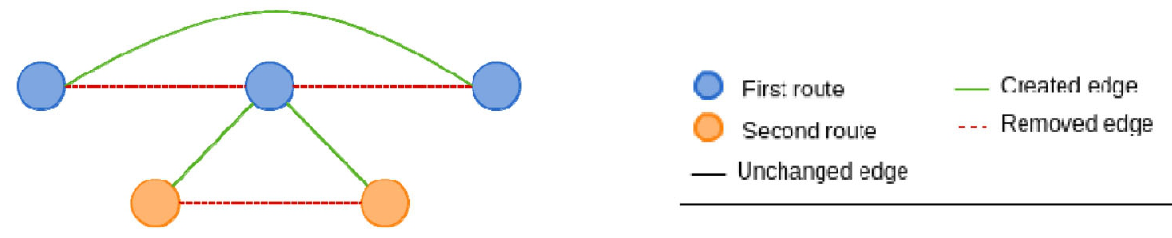
Figure 1. Shift exchange